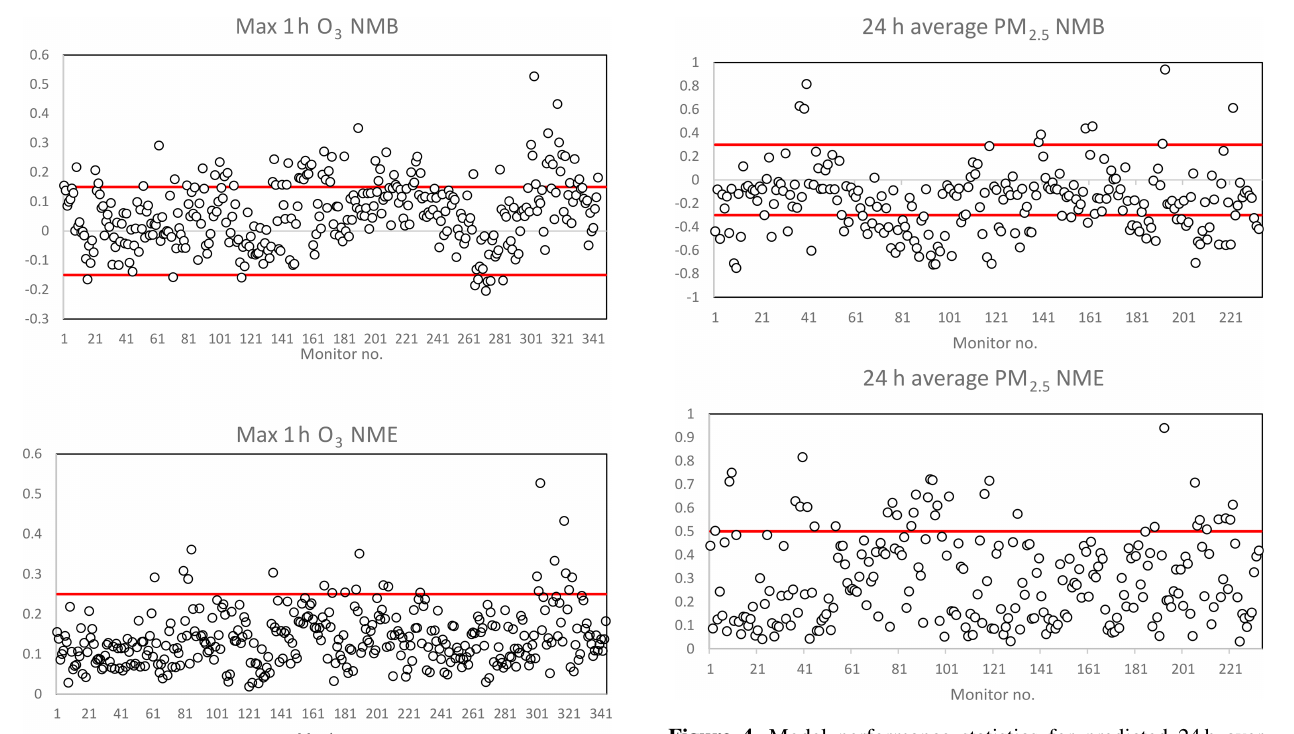
Figure 4. Model performance statistics for predicted 24h aver- age PM 2 . 5 against measured values. The red line represents perfor- Figure 3. Model performance statistics for predicted maximum 1h mance criteria of ± 0 . 30 for NMB and 0.50 for NME. Normalized O 3 against measured values. The red line represents performance mean bias and normalized mean error were calculated for available criteria of 0.15 for NMB and 0.25 for NME. NMB and NME were measurements against predictions at every monitor in the CBSA calculated for available measurements against predictions at every based on the U.S. EPA AQ Data Mart. Monitor number (horizontal monitor in the CBSA based on the U.S. EPA AQ Data Mart. Moni- axis), latitude and longitude, name, MO, MP, NMB, NME, FB, and tor number (horizontal axis), latitude and longitude, name, MO, MP, FE values are available for all species in the NMB, NME, FB, and FE values are available for all monitors in the Supplement. Table 2. Percent of monitors throughout the entire US domain that met performance criteria for normalized mean error (NME). Species Total number Percent that of monitors met NME performance criteria Max 1h O 3 344 95% Average 24h PM 2 . 5 234 85%